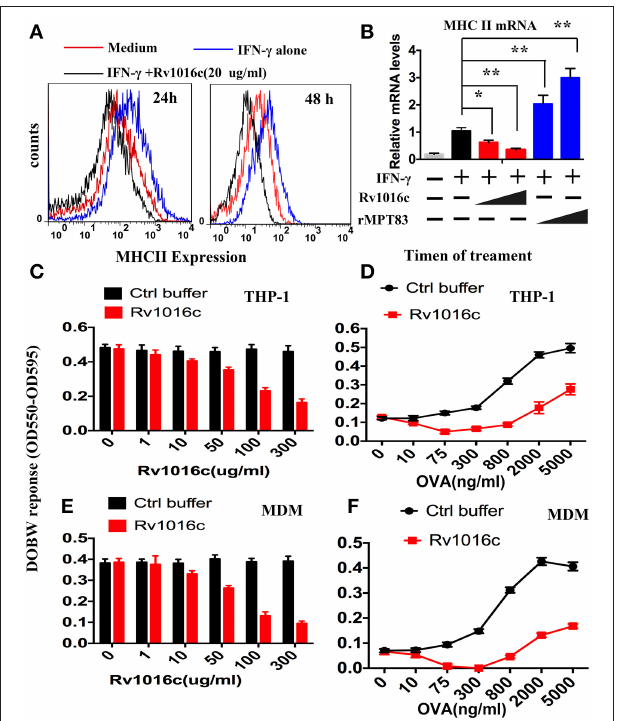
FIGURE 6 | Inhibition of MHC-II expression and Ag processing by Rv1016c lipoprotein is dependent on TLR 2. (A) THP-1 were pretreated with Isotype Ig G (30 µ g/ml) or Anti-TLR2 blocking Abs (30 µ g/ml) for 18 h, followed by treated with IFN- γ (15 ng/ml) for 24 h at 37 ◦ C, and then treated with or without Rv1016c-His (20 µ g/ml) for 24 h. Cells were then incubated with FITC-conjugated anti-MHC II or isotype Ig G control Abs for 30 min in the dark room. MHC-II expression was washed and analyzed with a BD FACScan flow cytometer. (B) Macrophages from WT, TLR2 − / − or TLR4 − / − mice were stimulated with IFN- γ (15ng/ml) for 24 h at 37 ◦ C, and then treated with or without Rv1016c-His (20 µ g/ml) for 24h. MHC-II expression was measured as previously described. 1 MFV was calculated as the MFV of cells stained with anti–MHC-II minus the MFV of cells stained with the isotype-control Ab. (C) Macrophages from WT, TLR2 − / − or TLR4 − / − mice were stimulated with IFN- γ (15 ng/ml) for 24 h at 37 ◦ C, and then treated with or without Rv1016c-His (20 µ g/ml) for 24 h. Then, cells were washed and incubated with indicated concentration of OVA 323 − 339 for 6 h. After fixed in 1% paraformaldehyde and washed extensively, the cells were finally incubated with DOBW T hybridoma cells for 24 h. Supernatants from the T hybridoma assay were assessed for IL-2 using a CTLL-2 cell bioassay. (D) THP-1 cells (1 × 10 5 cells/well) were pretreated with Isotype Ig G (30 µ g/ml), Anti-TLR2 blocking Abs (30 µ g/ml) or Anti-TLR4 blocking Abs (30 µ g/ml) for 18 h, and then incubated with or without Rv1016c (20 µ g/ml) in the presence of IFN- γ (15 ng/ml) for 24 h at 37 ◦ C. After washed with PBS and fixed in 1% paraformaldehyde, Rv1016c Ag-specific CD4 + T cells (1 × 10 6 cells/well) were added to the plates, and were co-cultured for 48h at 37 ◦ C. ELISA was used to assay the level of IL-2 in supernatant. (E) Macrophages (1 × 10 5 cells/well) from wild type, TRL2 − / − or TRL4 − / − mice were incubated with Rv1016c (20 µ g/ml) or medium in the presence of IFN- γ (15 ng/ml) for 24 h at 37 ◦ C. Cells were washed with PBS and fixed for 20 min in 1% paraformaldehyde. Then, 1 × 10 6 cells/well Rv1016c antigen-specific CD4 + T cells were co-cultured with macrophages for 48 h at 37 ◦ C. IL-2 level was assayed as previously described. All data were generated from three independent experiments and Data are shown as Means ± SD of triplicate wells. (** p < 0.01, *** p < 0.001 vs. corresponding